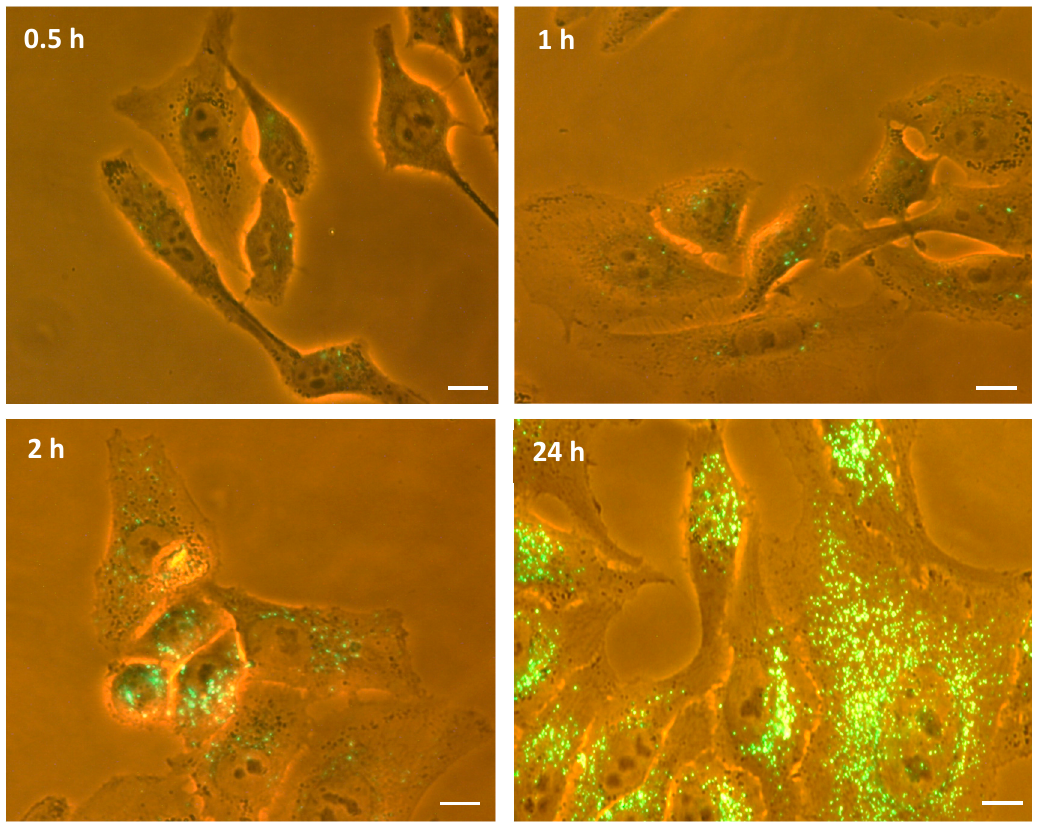
Figure 5. Kinetics of internalization of M-NVs stained with PHK67 dye into T98G cells at different time intervals (i.e., 0.5–1–2–24 h) visualized by inverted fluorescence microscope (40× magnification). Scale bar = 10 μ m.